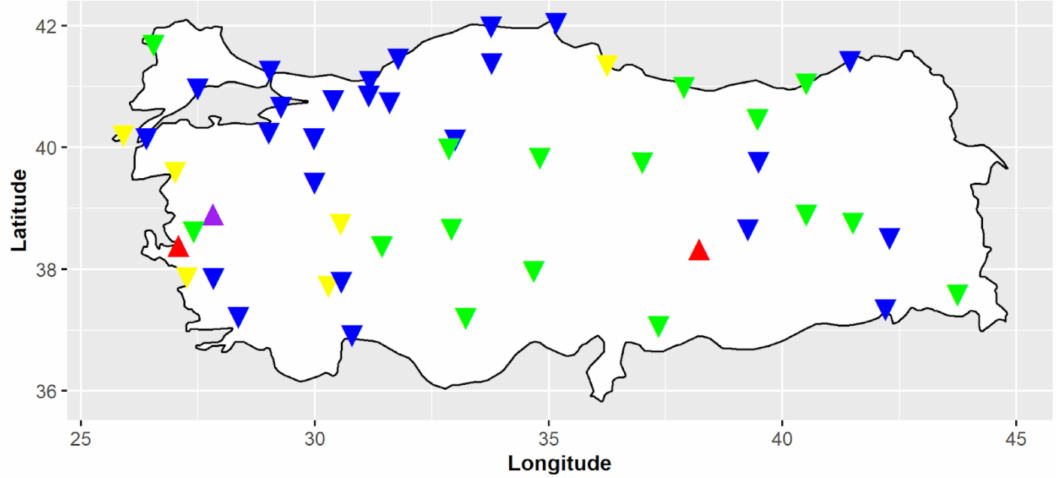
Figure A22. Same as Figure A13 but for September (See Figure A13 for